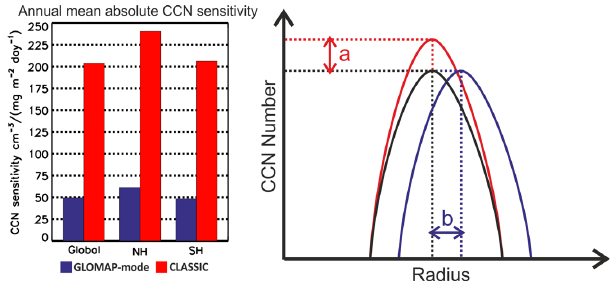
Fig. 5. Left panel: annual mean CCN sensitivity (global, Northern Hemisphere and Southern Hemisphere) for GLOMAP-mode and CLASSIC. Right panel: idealized responses to the same sulphur perturbation in the two different schemes. See text for